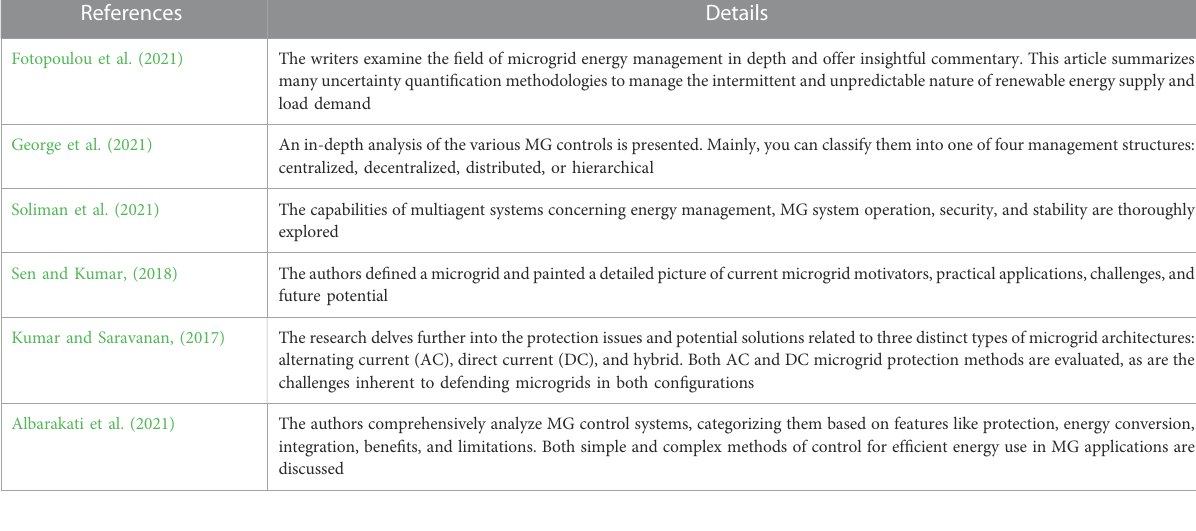
TABLE 1 The reviews related to energy management of MG.